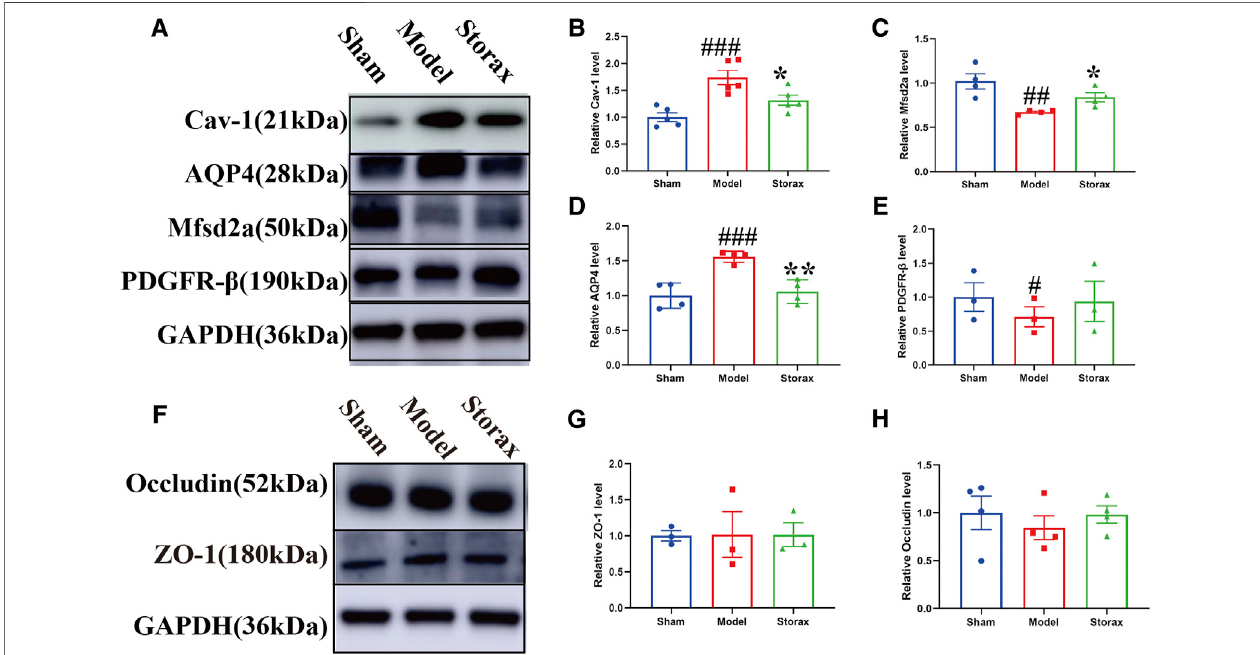
FIGURE4| EffectsofStoraxontheexpressionofBBB-relatedproteinsat6 hafterstroke. (A) RepresentativeimagesofWesternblottinganalysisofCav-1,AQP4, Mfsd2a and PDGF- β . (B – E) Quantitative data of Cav-1, AQP4, Mfsd2a and PDGFR- β expression, normalized to that of the Control group. (F) Representative images of Western blotting analysis of ZO-1 and Occludin. (G,H) Quantitative data of ZO-1 and Occludin expression, normalized to that of the Control group. Data were shown as the mean ± SEM. ## p < 0.01, ### p < 0.001 vs . Control group, * p < 0.05, ** p < 0.01 vs . Storax group, n = 3 – 5.